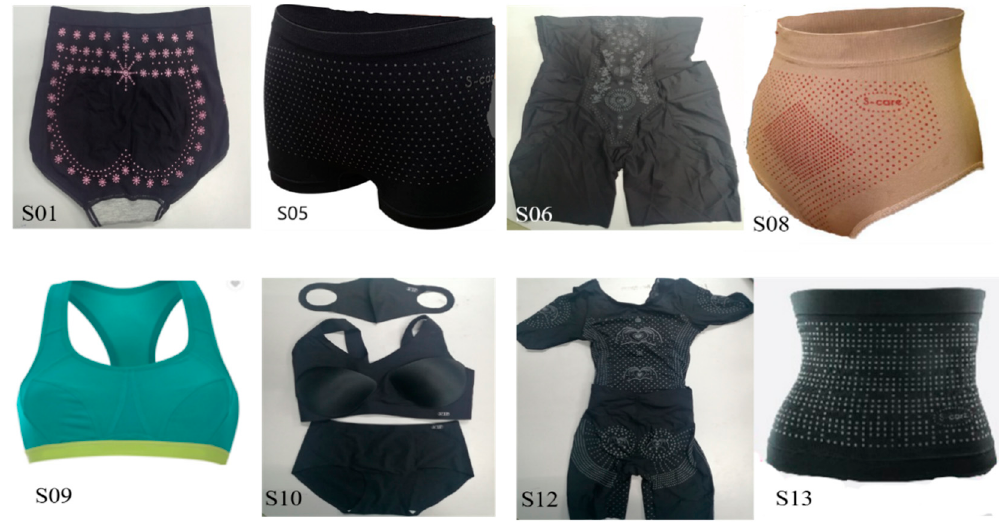
Figure 1. Undergarment samples.